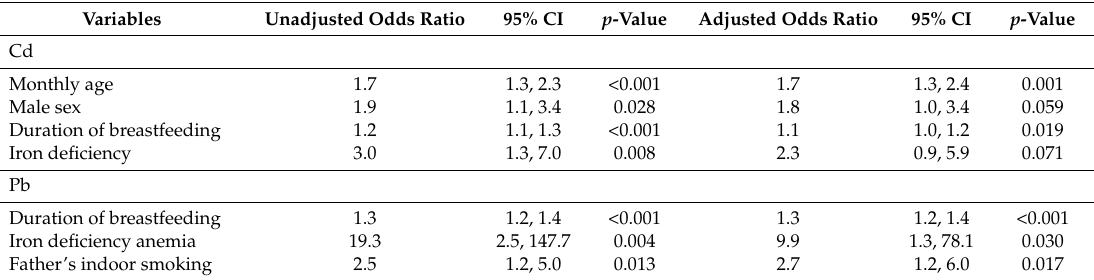
Table 6. Simple and multiple logistic regression analysis of Cd and Pb levels in 210 infants according to demographics, dietary parameters, and iron